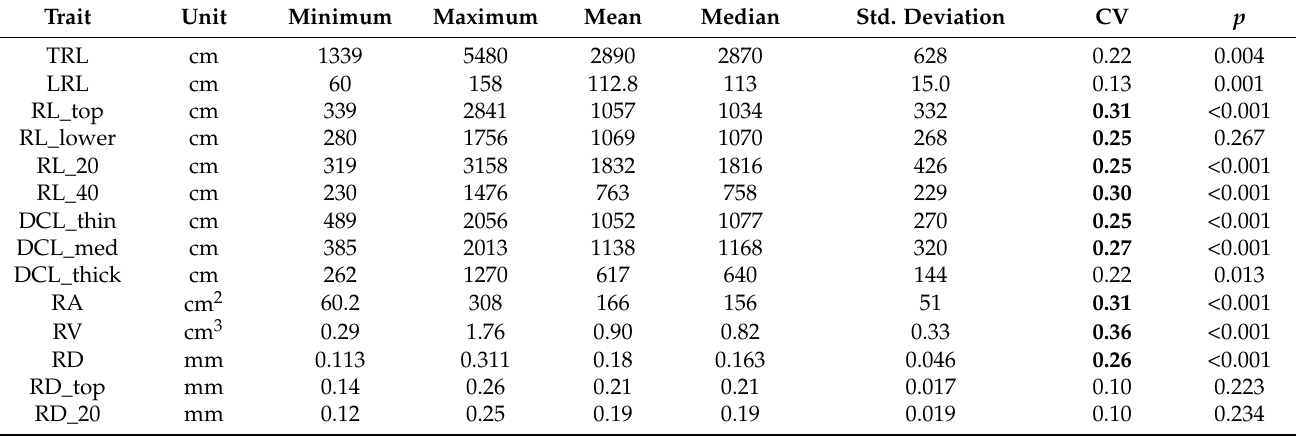
Table 2. Descriptive statistics of 23 root traits and three shoot traits in 189 barley genotypes grown in the semi-hydroponic phenotyping system for 30 days after transplanting in a temperature-controlled